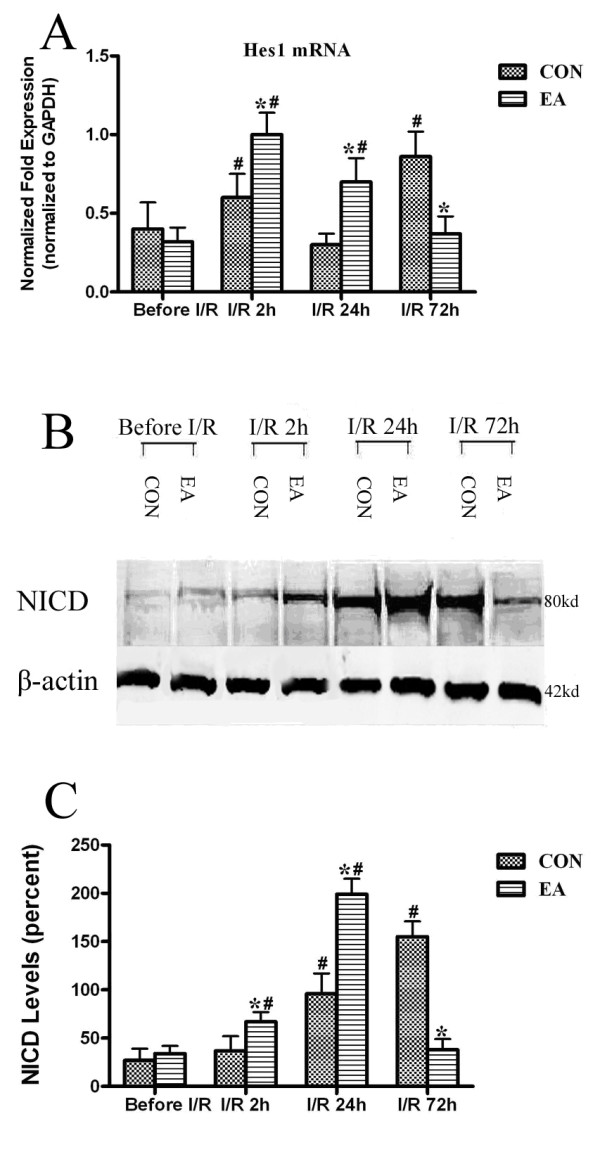
The quantification analysis of Hes1 mRNA and Notch1 NICD protein. (A) The quantification of the real-time PCR analysis of Hes1 mRNA in the striatum of rat brain compared with GAPDH respectively in CON and EA Before I/R (lane 1, 2), CON and EA I/R2h (lane 3, 4), CON and EA I/R24h (lane 5, 6), CON and EA I/R72h (lane 7, 8) groups. (B) Representative Western blot bands of Notch1 NICD (80 kDa) expression obtained from rats in CON and EA Before I/R (lane 1, 2), CON and EA I/R2h (lane 3, 4), CON and EA I/R24h (lane 5, 6), CON and EA I/R72h (lane 7, 8) groups. (C) The bar graph shows quantification of the Western blot analysis for the Notch1 NICD protein compared with β-actin. Pretreatment with EA significantly up-regulated the Hes1 mRNA and Notch1 NICD protein expressions at 2 and 24 h after the end of ischemia/reperfusion. While the expressions of Hes1 mRNA and Notch1 NICD protein of EA group were down-regulated at 72 h compared to CON group (*P < 0.05 vs. CON of the same time point, # P < 0.05 vs. before I/R of the same group).